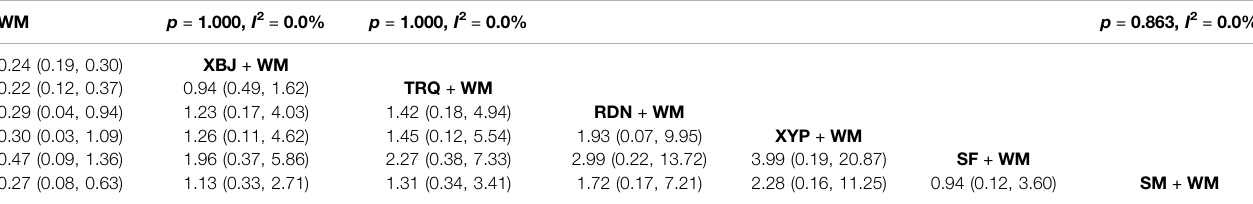
TABLE 2 | ORs with 95% CIs of the clinical effective